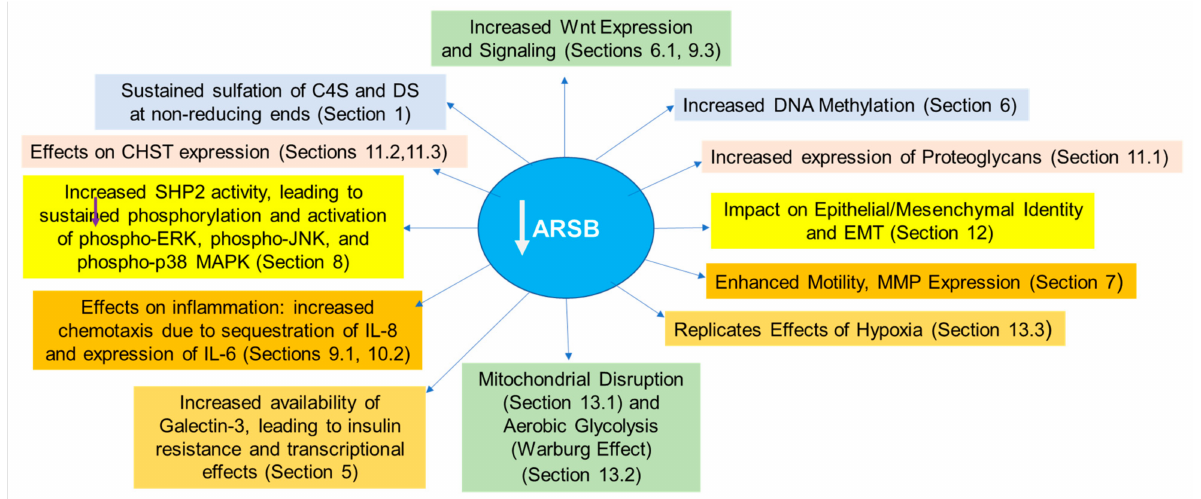
Figure 6. Predominant effects of decline in Arylsulfatase B (ARSB) in mammalian cells. Decline in ARSB leads to profound effects on vital cell processes in mammalian cells, as indicated in this report. C4S = chondroitin 4-sulfate; DS = dermatan sulfate; EMT = epithelial-mesenchymal transition; CHST = chondroitin sulfotransferase; ERK = extracellular-signal regulated kinase; MAPK = mitogen- activated protein kinase; JNK = c-Jun N-terminal kinase; SHP2 = tyrosine-protein phosphatase non-receptor type